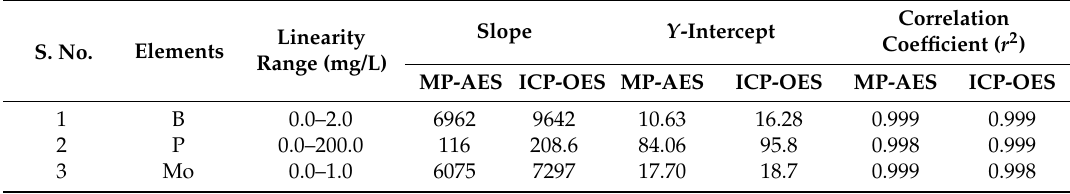
Table 4. Linearity data for boron, phosphorous and molybdenum using MP-AES and ICP-OES.